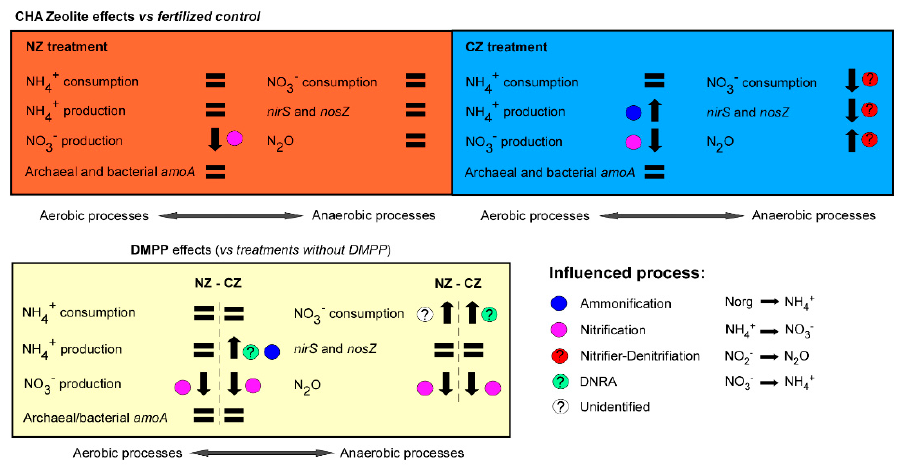
Figure 5. Summary of the main results. “=” symbols indicate no observed variations, arrows indicate an increase or decrease in the parameter. Question mark next to processes depicts a potential pathway that is supported by the data, but not directly measured, and hence the necessity to acquire more data. NZ treatment is the soil amended with 10% of CHA zeolite-tuff in natural state, while CZ is soil amended with 10% CHA zeolite-tuff enriched with NH 4+ . Supplementary Materials: The following are available online at www.mdpi.com/xxx/s1. Table S1: Primers used for quantitative PCR . Table S2: Quantitative PCR thermal profiles for the dif- ferent target genes.